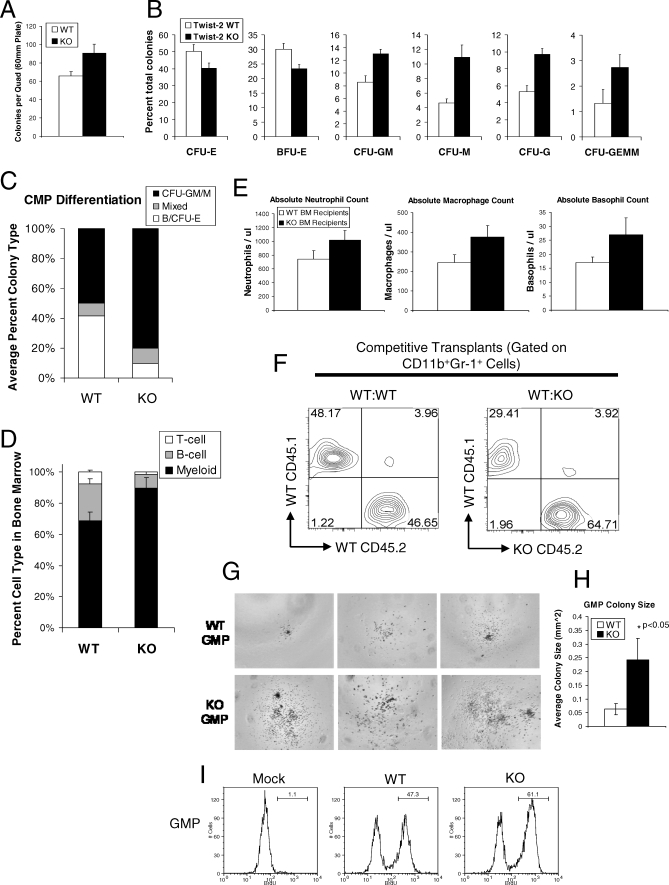
Twist-2 Regulates the Myeloid Differentiation and Proliferation of Hematopoietic Progenitors in an Intrinsic and Cell Autonomous Manner(A and B) Twist-2 KO BM cells are hypersensitive to GM-CSF–induced colony formation and skewed toward the differentiation of myeloid colonies. Cells cultured in MethoCult M3001 containing GM-CSF only (A), and MethoCult GF M3434 containing a growth factor and cytokine cocktail (B) in vitro are shown. Colonies were counted on day 12 of culture (n = 5 plates per group), and results are representative of three independent experiments.(C) Single-cell Lin−IL7R−Sca-1−c-Kit+CD34+FcγRII/III− CMPs from Twist-2 KO mice or WT littermate BM were sorted into individual wells of a 96-well plate containing MethoCult and cultured for 10 d. Resultant colonies were scored by their respective type (BFU-E/CFU-E, mixed GEMM, and CFU-GM/CFU-M). Data are representative of three independent experiments.(D and E) Transplantation of Twist-2 KO BM results in increased myeloid cell counts in irradiated syngeneic hosts. Whole BM from Twist-2 KO mice or WT littermates was injected retro-orbitally into lethally irradiated syngenic mice (2 × 106 cells/mouse, n = 6 per group). After 4 wk, BM was analyzed and relative percentages of CD4+ and CD8+ T cells, B220+Gr-1−CD11b− B cells, and B220−Gr-1+CD11b+ myeloid cells were calculated (D). Peripheral blood was analyzed in a separate cohort at 8 wk by automated CBC with differential (E). Data are representative of two independent experiments.(F) For competitive transplants, whole BM from CD45.2 Twist-2 KO mice or CD45.2 WT littermates was mixed 1:1 with WT CD45.1 BM and injected retro-orbitally into lethally irradiated CD45.1 congenic mice (400 × 103 cells/mouse, n = 5 per group). After 4 wk, BM was analyzed, and relative percentages of Gr-1+CD11b+ myeloid cells expressing CD45.1+ and CD45.2+ were analyzed. Results are representative of two independent experiments.(G and H) Increased size and number of myeloid colonies of Twist-2 KO GMP in vitro. Single-cell Lin−IL7R−Sca-1−c-Kit+CD34+FcγRII/IIIhigh GMPs were sorted directly into individual wells of 96-well plates containing MethoCult (GF M3434) and cultured for 5 d. Images are representative of three independent experiments (G). Colonies were imaged and digitally analyzed (n = 20 colonies per group) (H). Error bars indicate SD.(I) Twist-2 KO GMPs are hyperproliferative in vivo. Twist-2 KO and WT mice were injected intraperitoneally with 170 μg/kg BrdU or PBS. After 2 h, mice were sacrificed and BM was stained for GMP surface markers and BrdU. Proliferating BrdU+ populations in the gated Lin−IL7R−Sca-1−c-Kit+CD34+FcγRII/IIIhigh GMPs are shown from one of three repeated experiments.